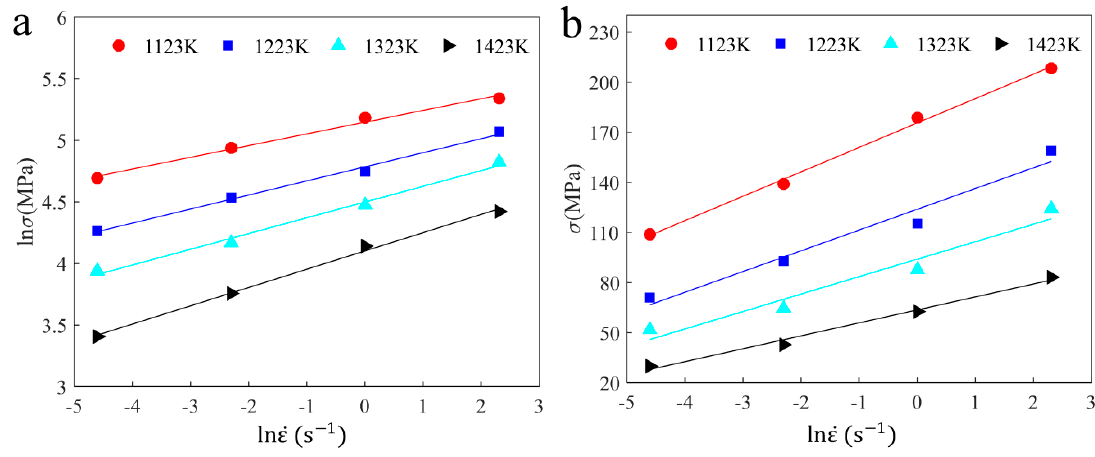
. ε − . ε − σ ln σ , ( b ) l n